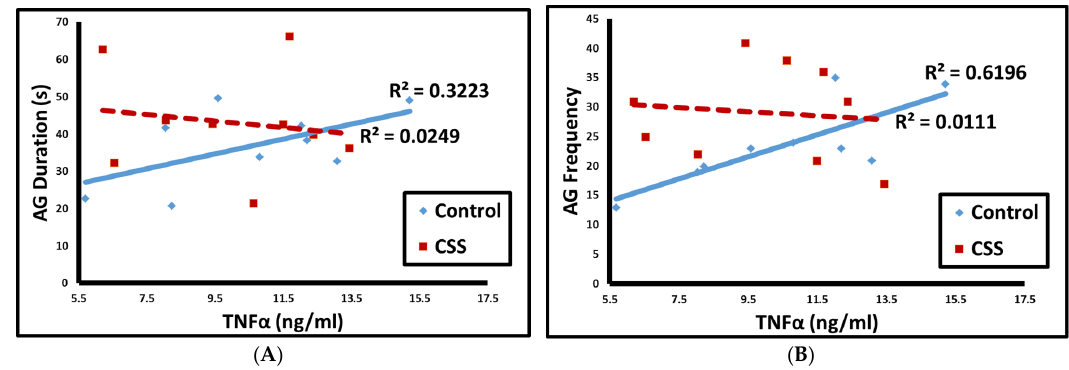
Figure 2. Correlations between TNF and AG investigation duration ( A ) and frequency ( B ). Solid blue line = control, dashed red line = CSS.